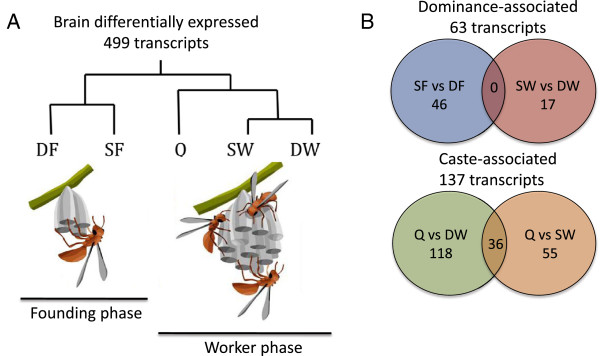
Patterns of gene expression in brains of dominant and subordinate wasps. A summary of the brain microarray data, for 499 differentially regulated transcripts across the five groups (DF = dominant foundress, SF = subordinate foundress, DW = dominant worker, SW = subordinate worker, Q = queen). A) Consensus clustering analysis (from both principal components analysis and hierarchical clustering) shows that many transcripts showed a pattern that corresponds to the social environment (founding phase or worker phase) and/or season. Wasp nest cartoons adapted from [37]. B) Venn diagrams summarizing the number of differentially regulated transcripts associated with either dominance status (top) or caste (bottom) and showing the overlaps between contrasts used to identify 'brain dominance-associated' transcripts (top) and 'brain caste-associated' transcripts (bottom).